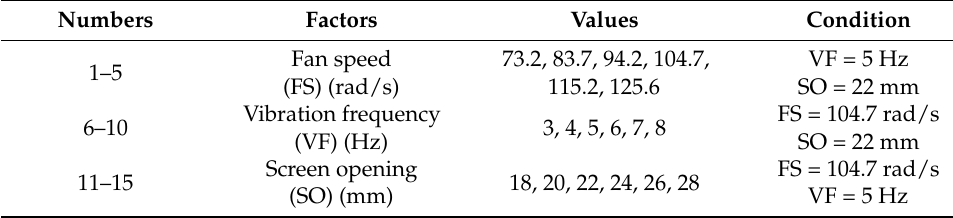
Table 1. Experimental scheme design of the single-factor experiment.